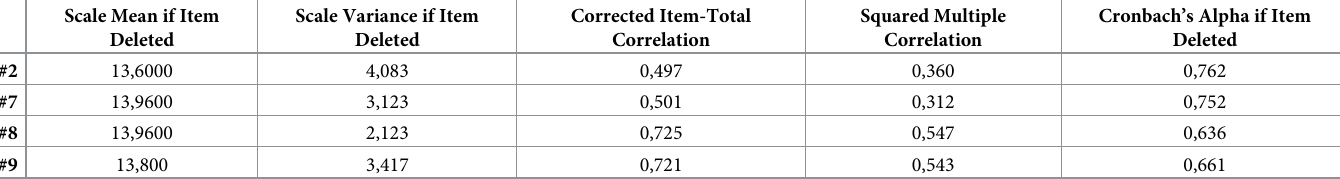
Table 20. Item-total statistics for subscale 4